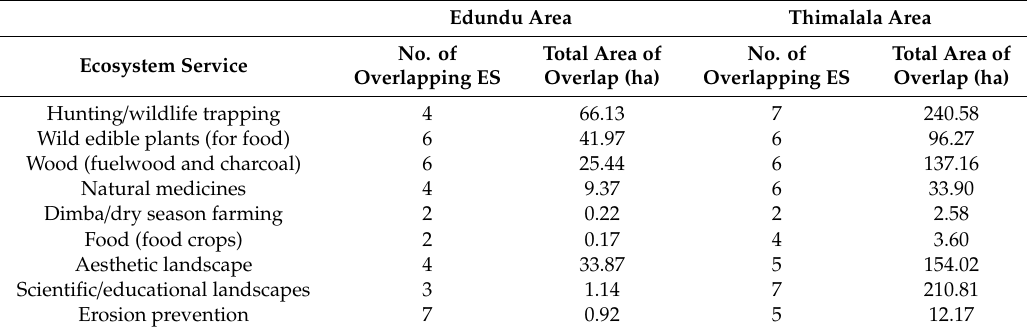
Table 8. Multiple-use ecosystem services in the village areas.